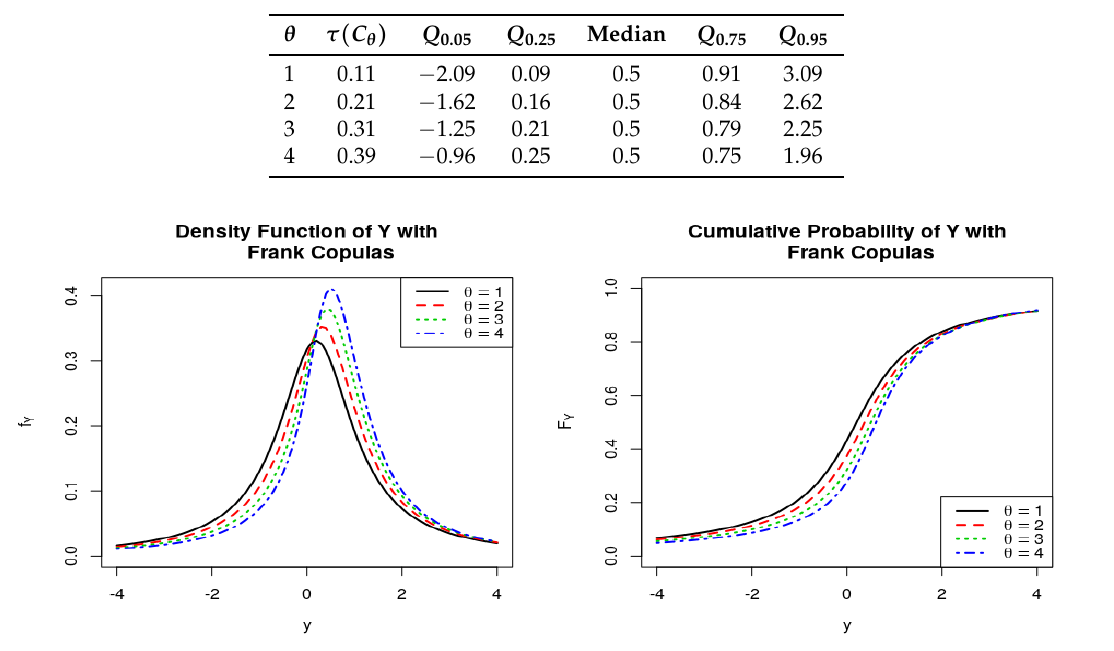
Figure 9. PDF and CDF of quotient of the ratio Y = X 1